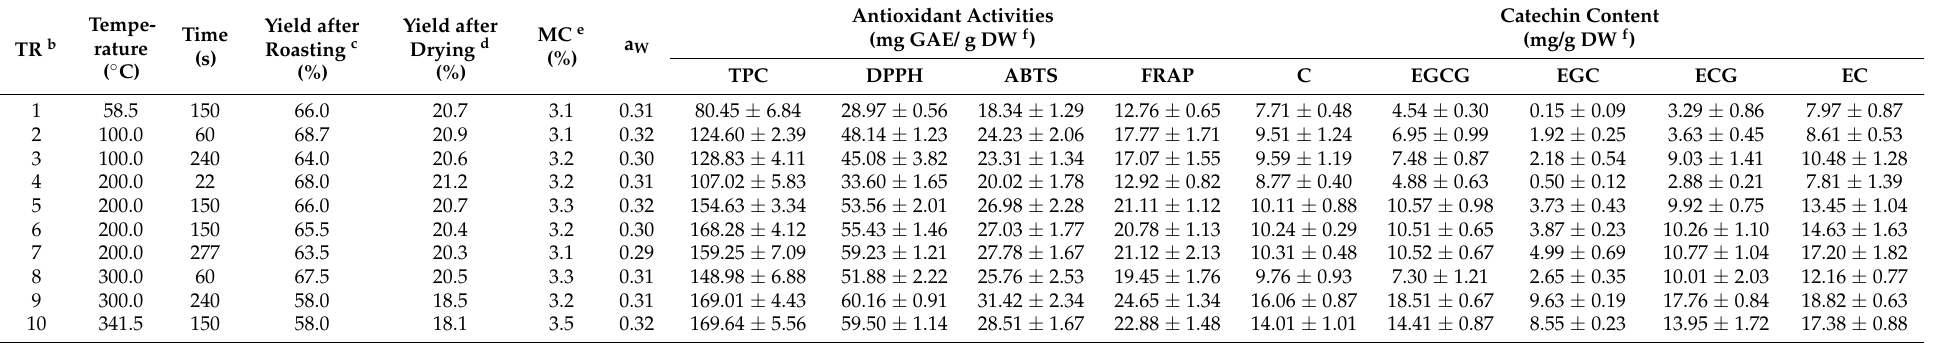
Table 1. Operating parameters of roasting temperature and time for all 10 runs carried out according to the central composite design (CCD) and the responses for green tea production by CCD a